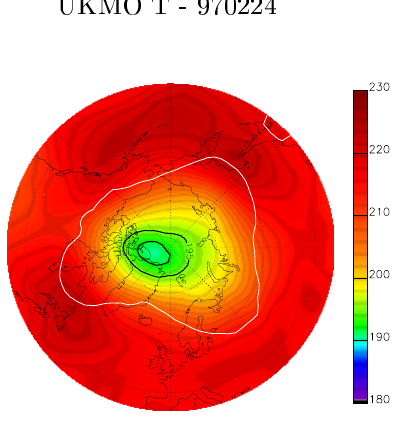
Fig. 1. False color maps of UKMO temperature at 50hPa at 12:00UTC on (from top to bottom): 31 January, 24 February and 20 March 1997. Superimposed in black on the maps are the 195 and 192K temperature contours to approximately represent var- ious PSC existence thresholds. Superimposed in white are the 2 . 8 · 10 − 4 Km 2 Kg − 1 s − 1 UKMO isentropic PV contours at 475K, as representative of the steepest PV gradient, to indicate the approx- imate edge of the